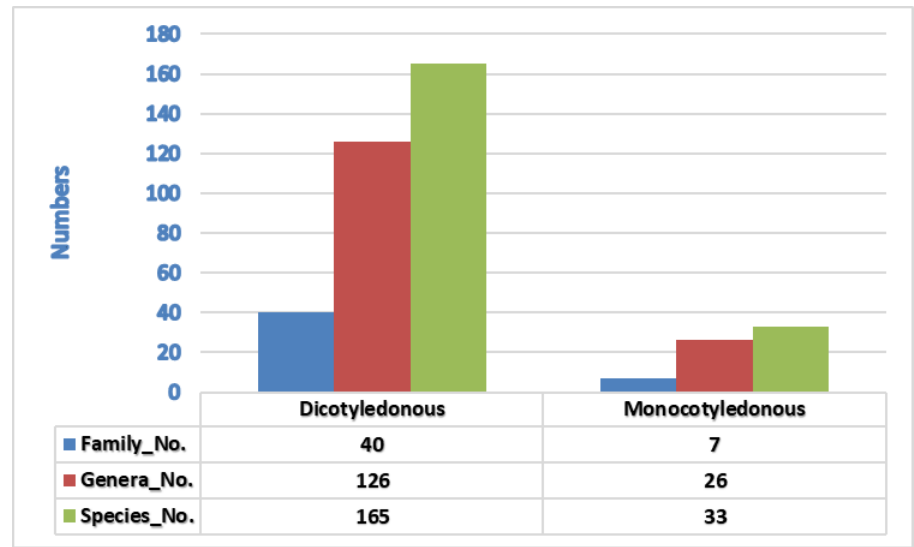
Figure 3. Histogram of the family, genera, and species number based on class Dicotyledonous and Monocotyledonous in Jabal Al-Ward.